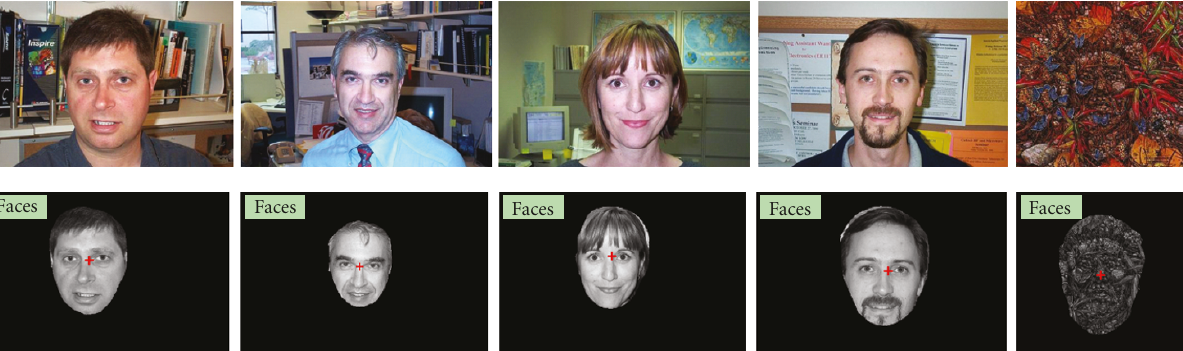
Figure 29: Examples of face detection and segmentation.